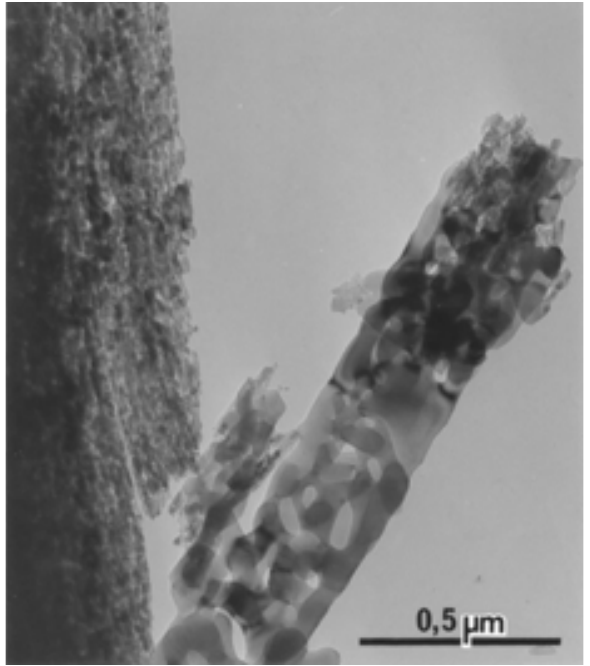
pseudoboehmite fired at 1200 °C.